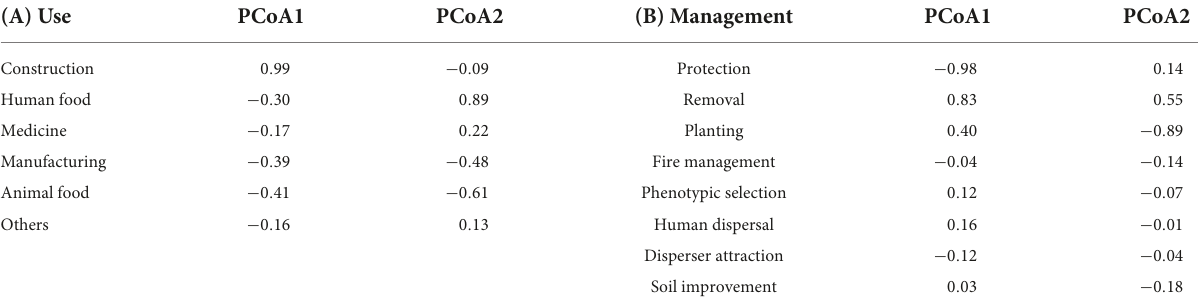
TABLE 2 Correlations between original variables and the two main axes of the Principal Coordinate Analysis (PCoA) performed to summarize the composition (percent abundance per specialist, using the Bray–Curtis distance) of (A) use and (B) management